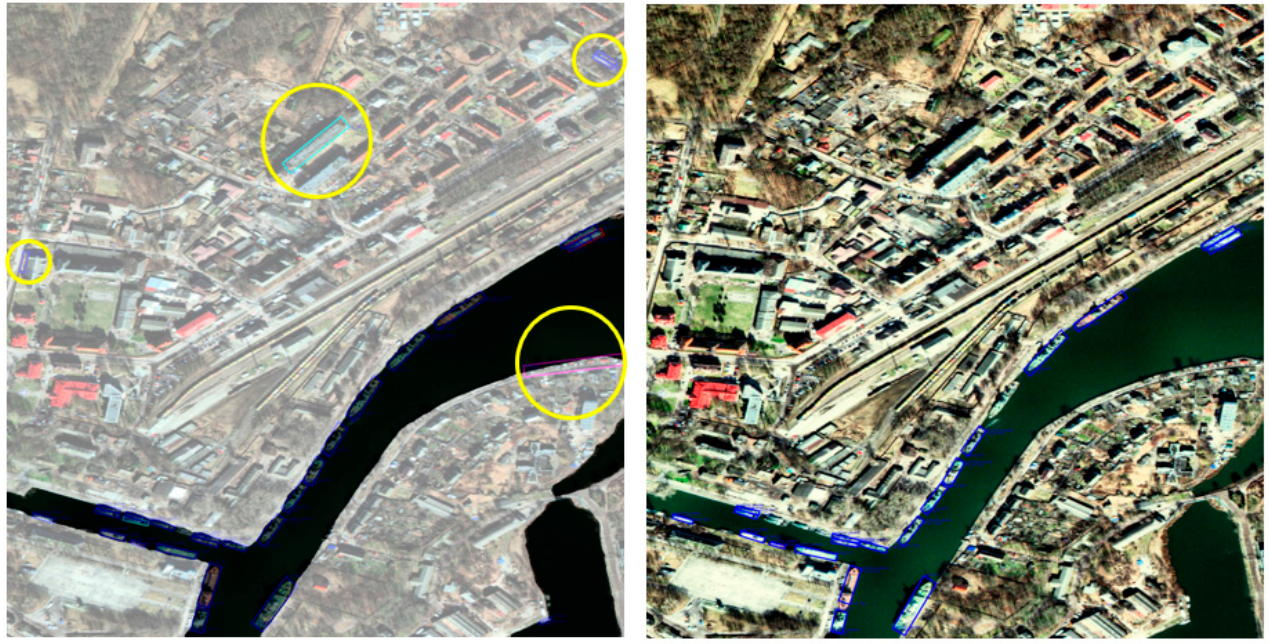
Figure 6. Result of applying FDSESI post-processing. The yellow circle implies false detection on land. The left image implies that the prediction ship of MSD overlaps the area of the sea and land segment mask. The right image implies